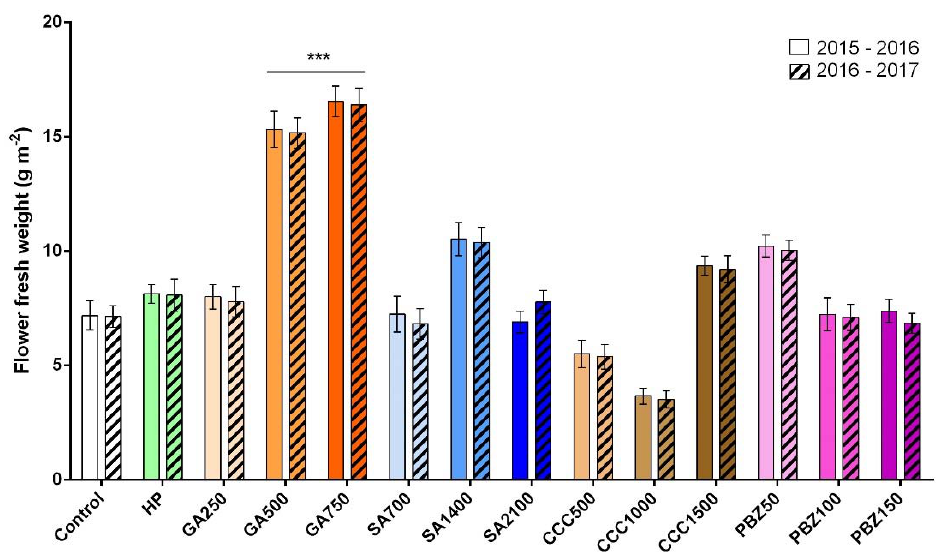
Figure 2. Effects of saffron corm priming with distilled water and four different growth regulators on flower fresh weight grown under field condition. HP, hydropriming; GA, gibberellic acid; SA, salicylic acid; CCC, chlormequat chloride; PBZ, paclobutrazol. Data are shown as mean ± standard deviation; *** p < 0.001 vs. control group. The empty white and colored columns correspond to the data for the years 2015–2016. The white and colored columns with oblique lines correspond to the years 2016–2017.